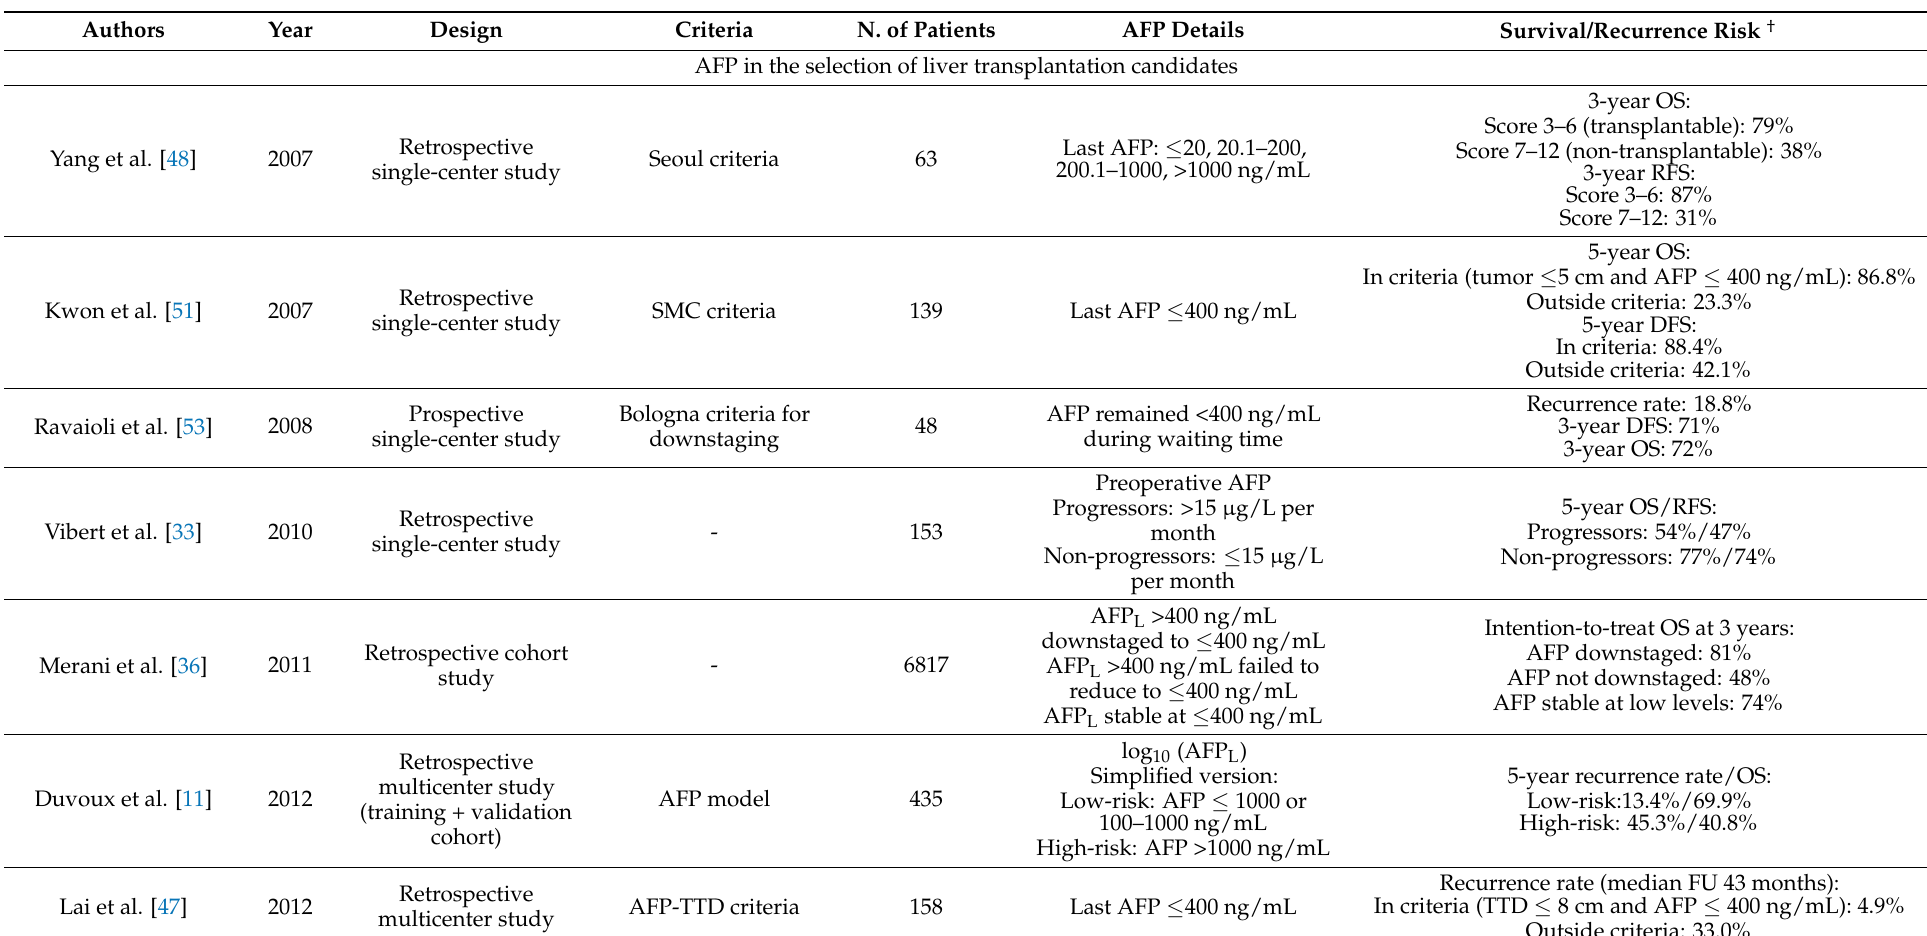
Table 2. Selected studies investigating the role of AFP in liver transplantation as a marker of prognosis and risk of